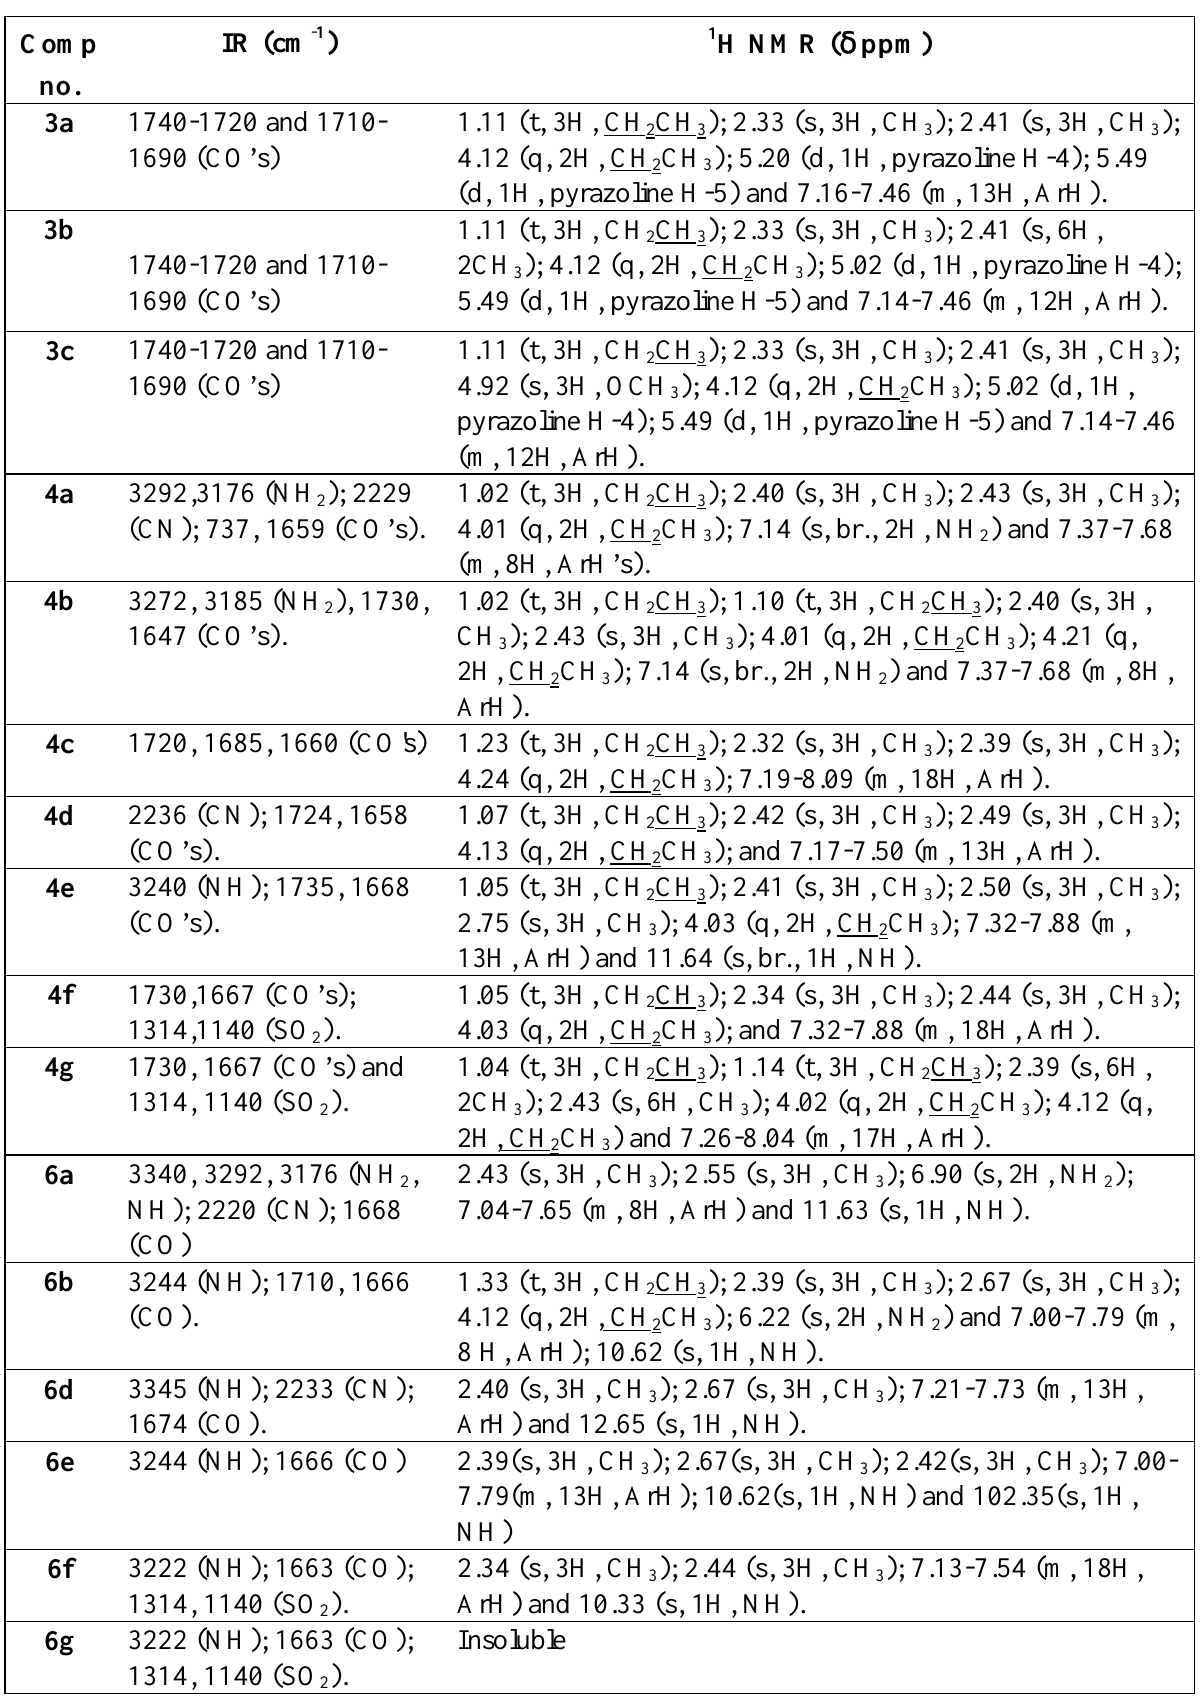
Table 2. IR and 1 H-NMR spectroscopic